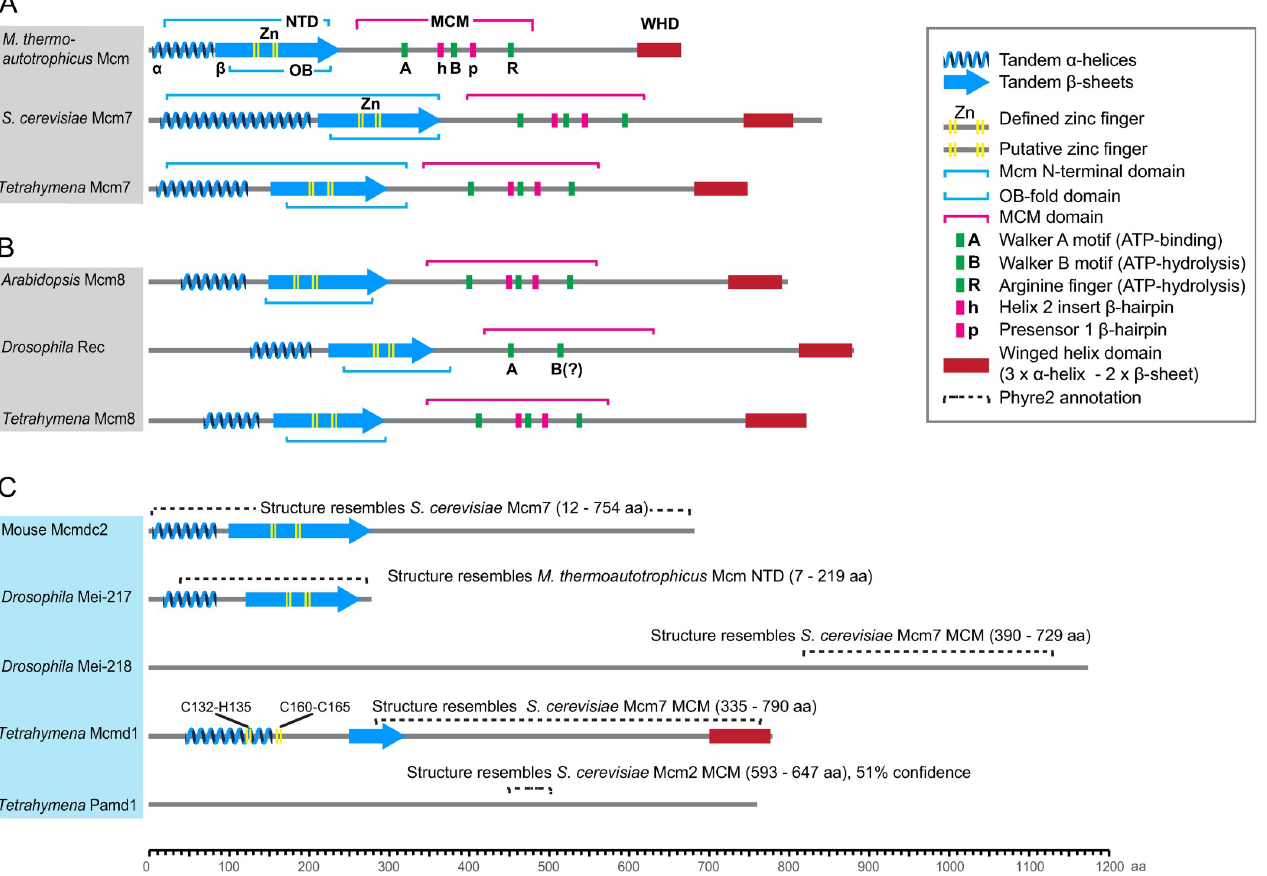
Fig 3. Domain organization of MCM-family proteins. (A) Representative members of core MCM family proteins including the Archaean MCM (here: Methanothermobacter thermautotrophicus ) and eukaryotic Mcm2-7 replicative helicases, represented by budding yeast ( Saccharomyces cerevisiae ) and Tetrahymena Mcm7. The proteins have a conserved structure consisting of a conserved N-terminal domain (NTD), an MCM domain (also called AAA + ATPase domain), and a C-terminal winged helix domain (WHD). The NTD consists of tandem α -helices, a zinc finger, and an oligonucleotide/ oligosaccharide-binding fold (OB-fold) consisting of tandem β -sheets. The MCM domain contains conserved Walker A, Walker B, and Arginine finger motifs that are required for ATPase activity. It also has a Helix 2 insert β -hairpin and a presensor 1 β -hairpin that are required for DNA unwinding and DNA binding, respectively. (B) Examples of Mcm8 proteins. Mcm8 sequences are divergent from those of MCM replicative helicases, but their secondary structures are similar. Mcm8 proteins have a conserved MCM domain (except for Drosophila Rec) and WHD. (C) Examples of meiotic MCM domain proteins. The meiotic MCM domain is structurally similar to the core MCM domain (Phyre2 prediction, 100% confidence) but lacks the signature motifs that are required for ATPase activity, DNA unwinding, and DNA binding. Drosophila Mei-217 and Mei-218 probably originated from the splitting of an ancestral MCM protein [18], with Mei-217 carrying the NTD and Mei-218 the MCM domain. Tetrahymena Mcmd1 shares a somewhat greater primary sequence homology with MCM replicative helicases compared with the others, whereas Pamd1 is the most divergent protein. Pamd1 has a short region with weak structural similarity (Phyre2 prediction, 51% confidence) to the MCM domain, making an evolutionary common origin doubtful. OB-folds were annotated using the Gene3D prediction tool of the InterProScan software package [21]. MCM domains were annotated using Pfam prediction (InterProScan). α -helices and β -sheets were annotated using the JURY results from the Jpred server [22]. Structural similarity analysis was done with Phyre2 [23].